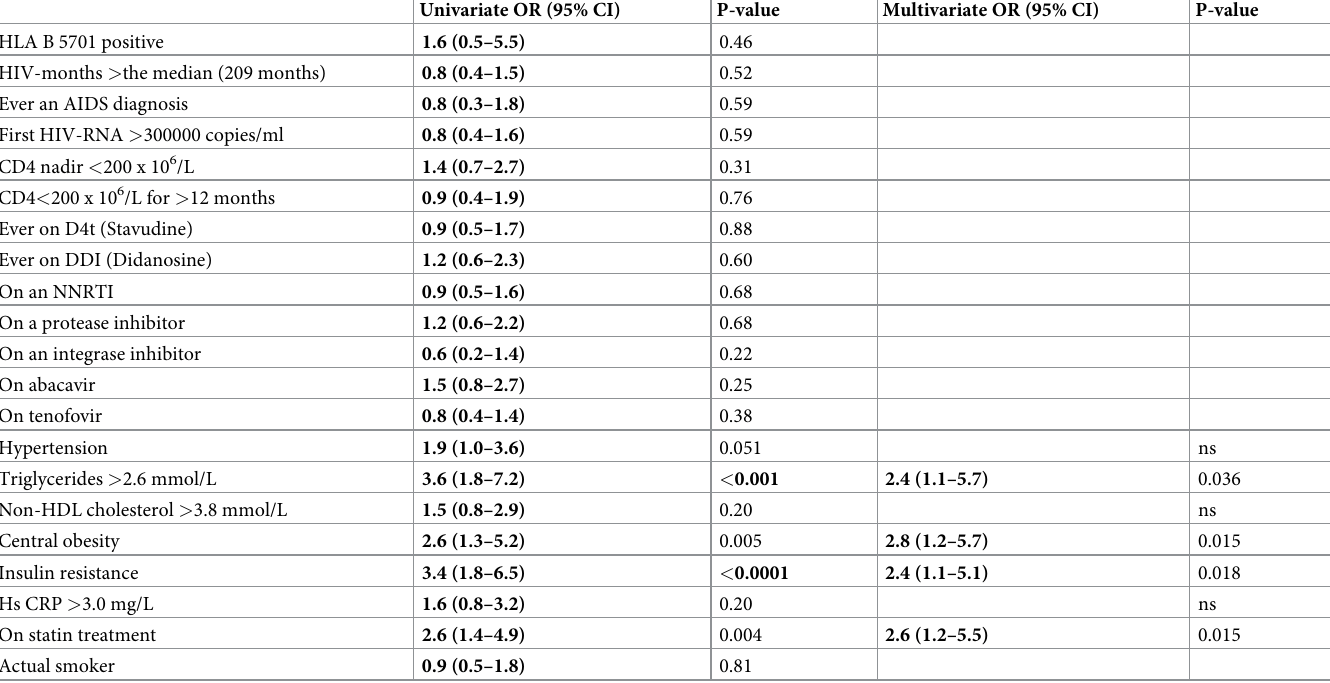
Table 2. HIV-parameters, treatment, metabolic and inflammatory factors at baseline in relation to T2D development during follow up (n = 505). Uni and multivar- iate analysis at baseline. The multivariate analysis was controlled for age. All parameters with p < 0.20 in the univariate analysis were entered in the multivariate equation. Odds Ratio (OR) and 95% confidence interval.